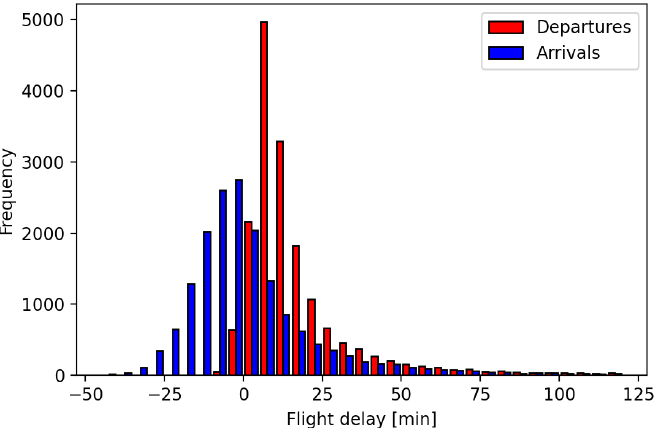
Figure 2. Histogram of the flight departure and arrival delays in the period January 2017–February 2020 at Rotterdam